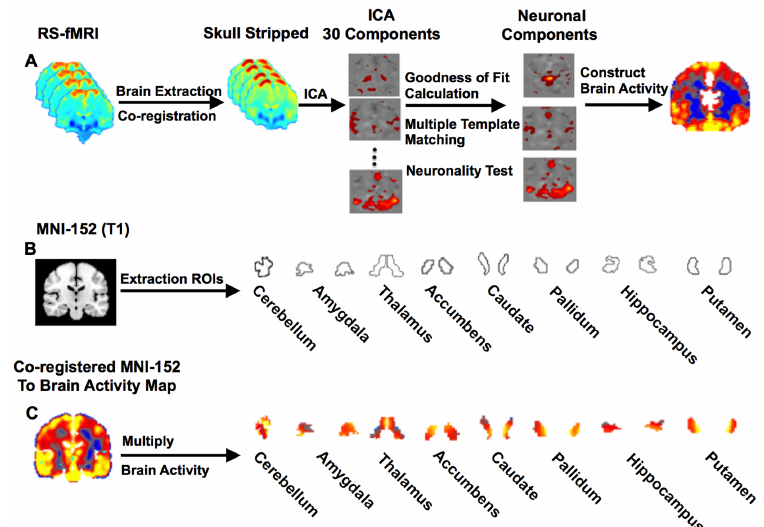
Fig 2. Brain activity from RS-fMRI. Schematic diagramof the brain activity (BOLD signalamplitude) measurement in different brain regions. (A) Steps involvedin calculatingthe brain activity maps from the RS- fMRI. (B) Regionsof interest extracted from MNI-152 space. (C) Activity maps within each regionof interest from one subject.